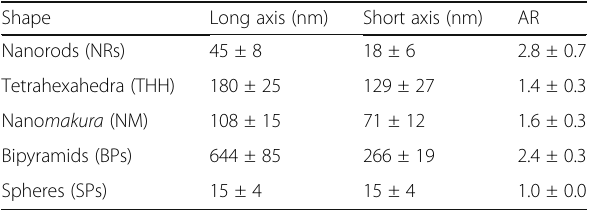
Table 2 Size distribution analysis of Au NSs of different shapes. The average size of NSs was determined from TEM images counting over 100 NSs (Additional file 1: Figure S2, ESI † ). The aspect ratio (AR) is calculated as the ratio of the long axis to the short